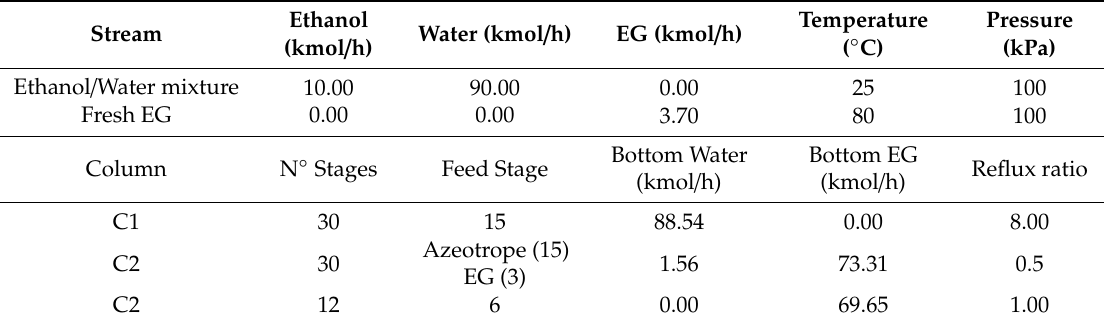
Table 2. Decision variables used in the